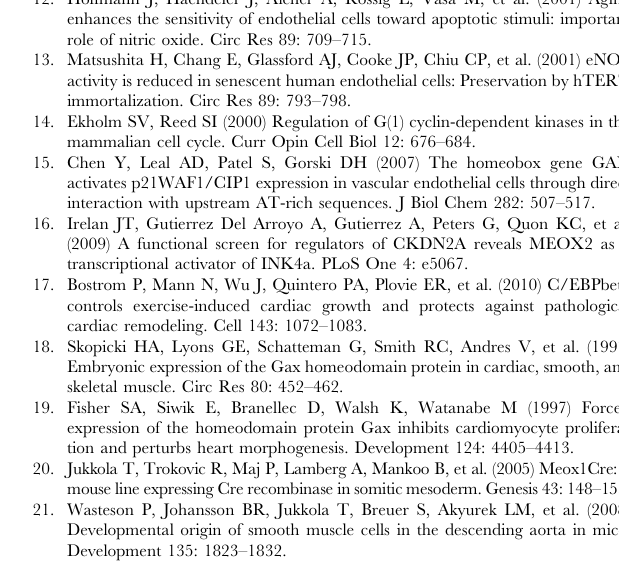
Figure S5 Deletion of the HQ rich domain of MEOX2 does not alter protein expression, localization or